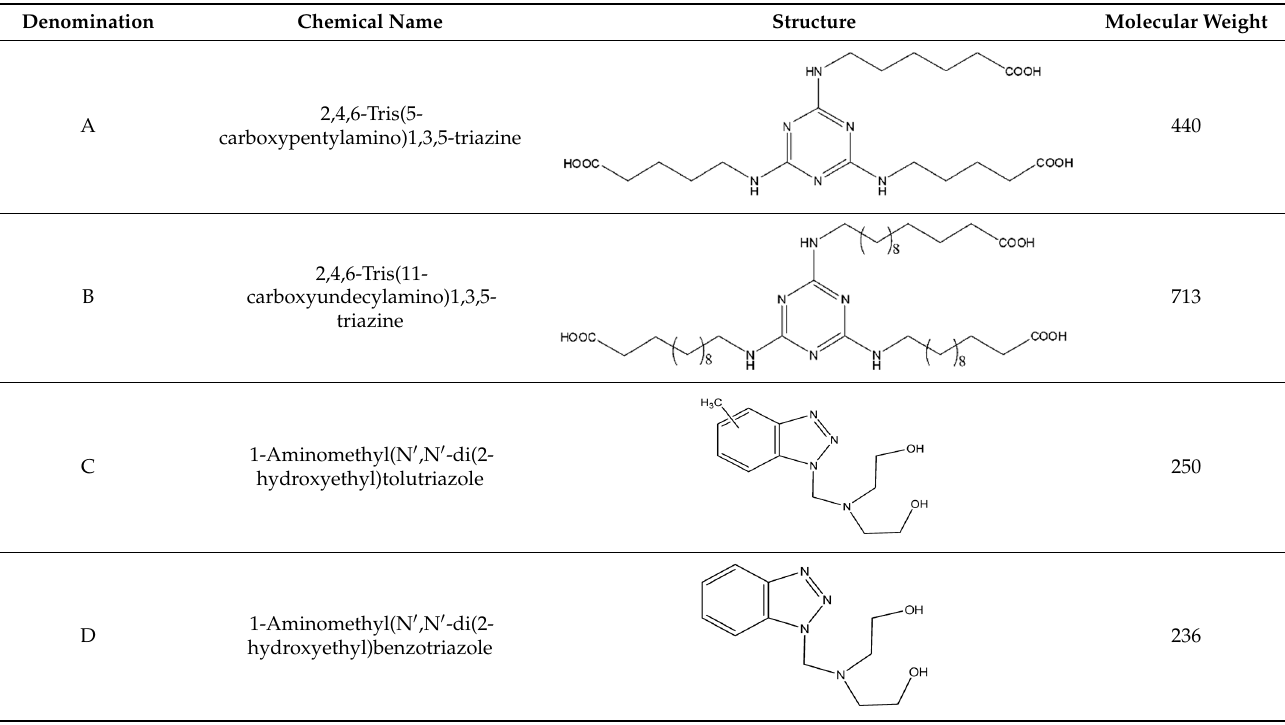
Table 2. The corrosion inhibitors used in this study.